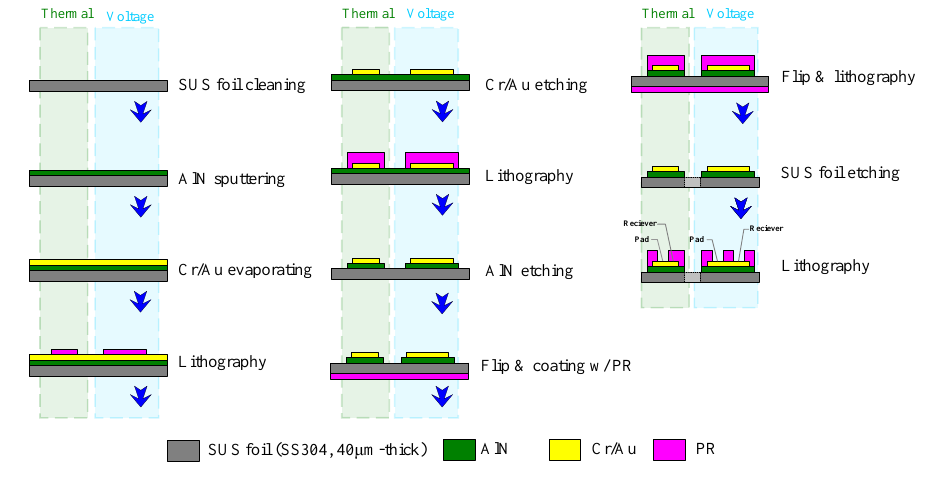
Figure 2. Flowchart for fabricating micro temperature and voltage